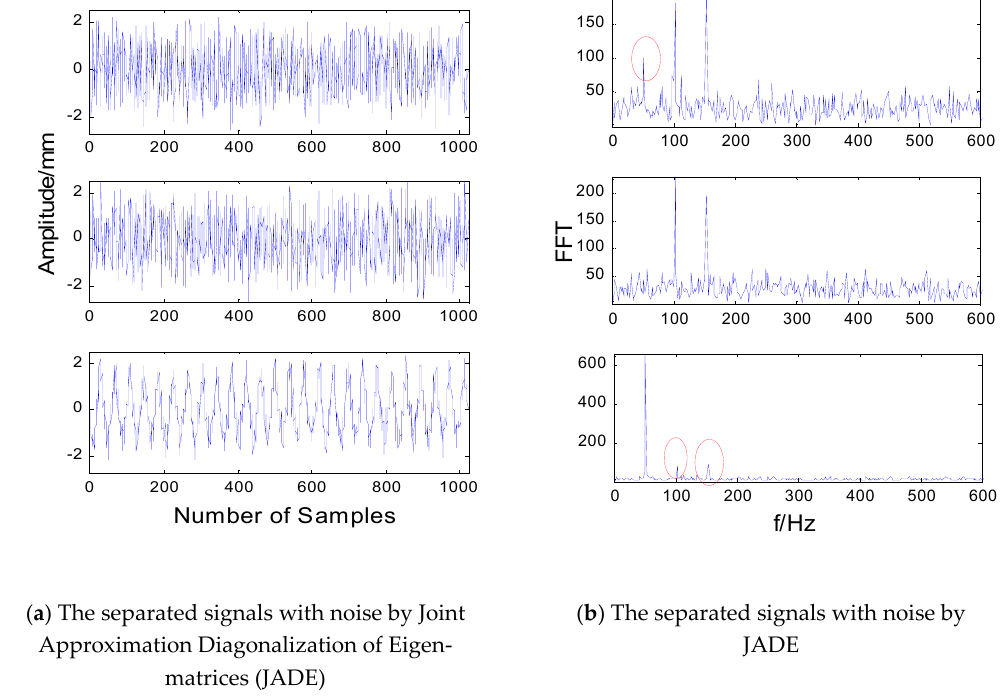
Figure 4. The frequency domain signals of the JADE algorithm.